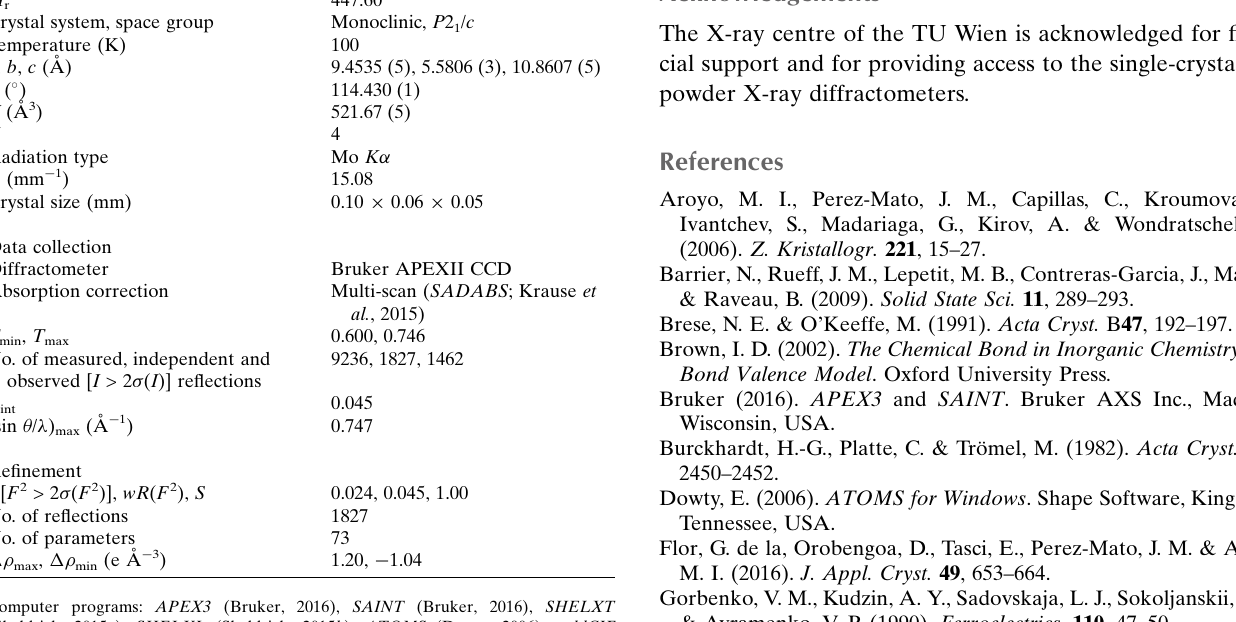
Table 2 Experimental details. Crystal data Chemical